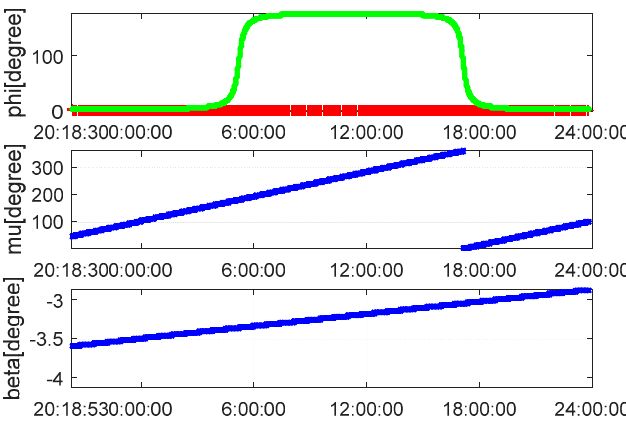
Figure 9. The attitude switch of BDS C10.